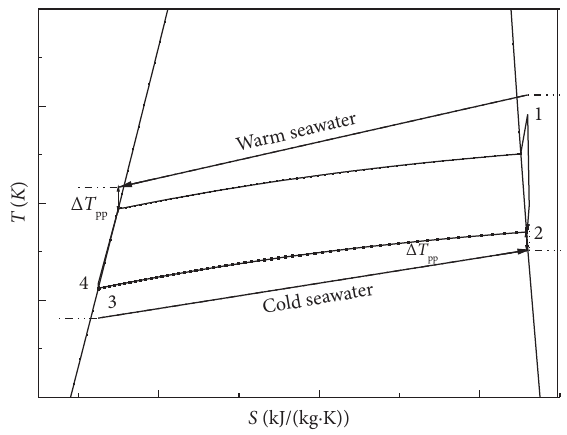
Figure 2: ORC with zeotropic working fuid in the T - S diagram. Figure